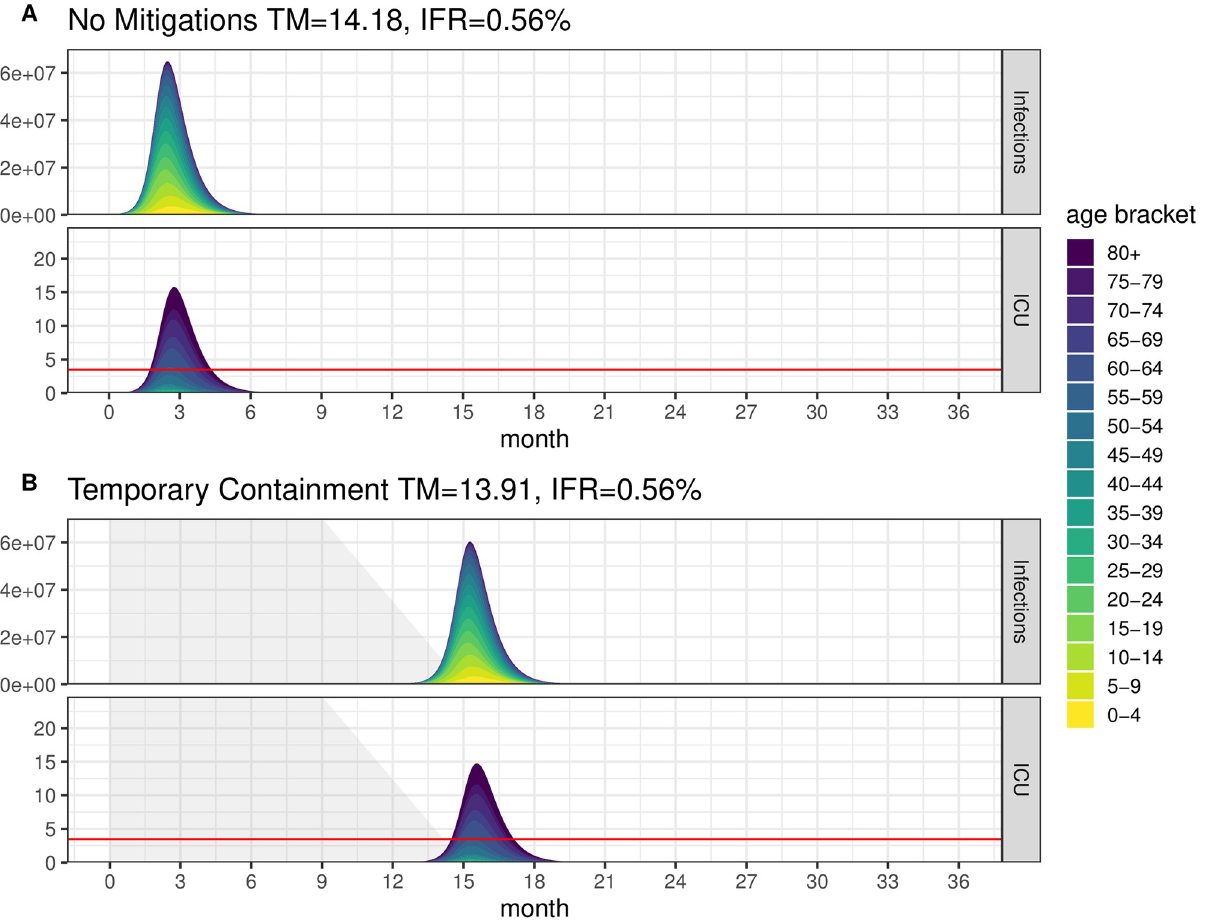
Fig 2. A : No mitigations. B : Containment followed by resumption in transmission levels between 9 and 15 months. (Scale for ICU figure is beds required per 10,000 people in population).